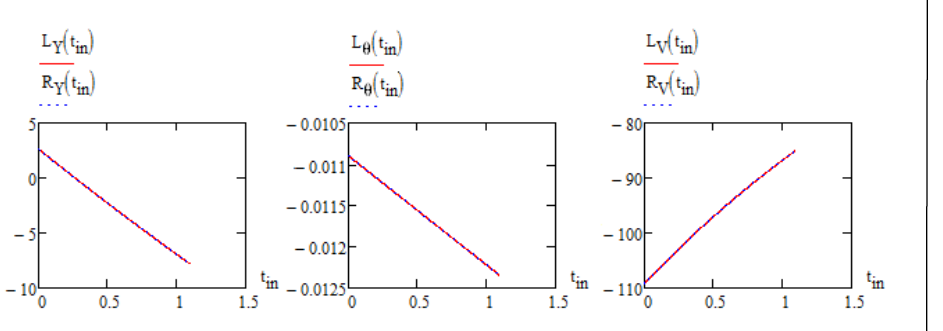
Figure 7 – A proof of the numerical solution for the second, third and fourth differential equation